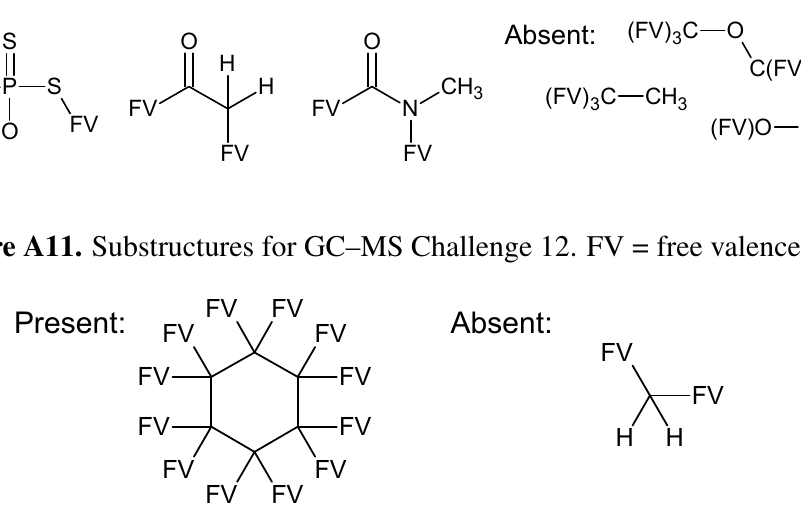
Figure A10. Substructures for GC–MS Challenge 11. FV = free valence.